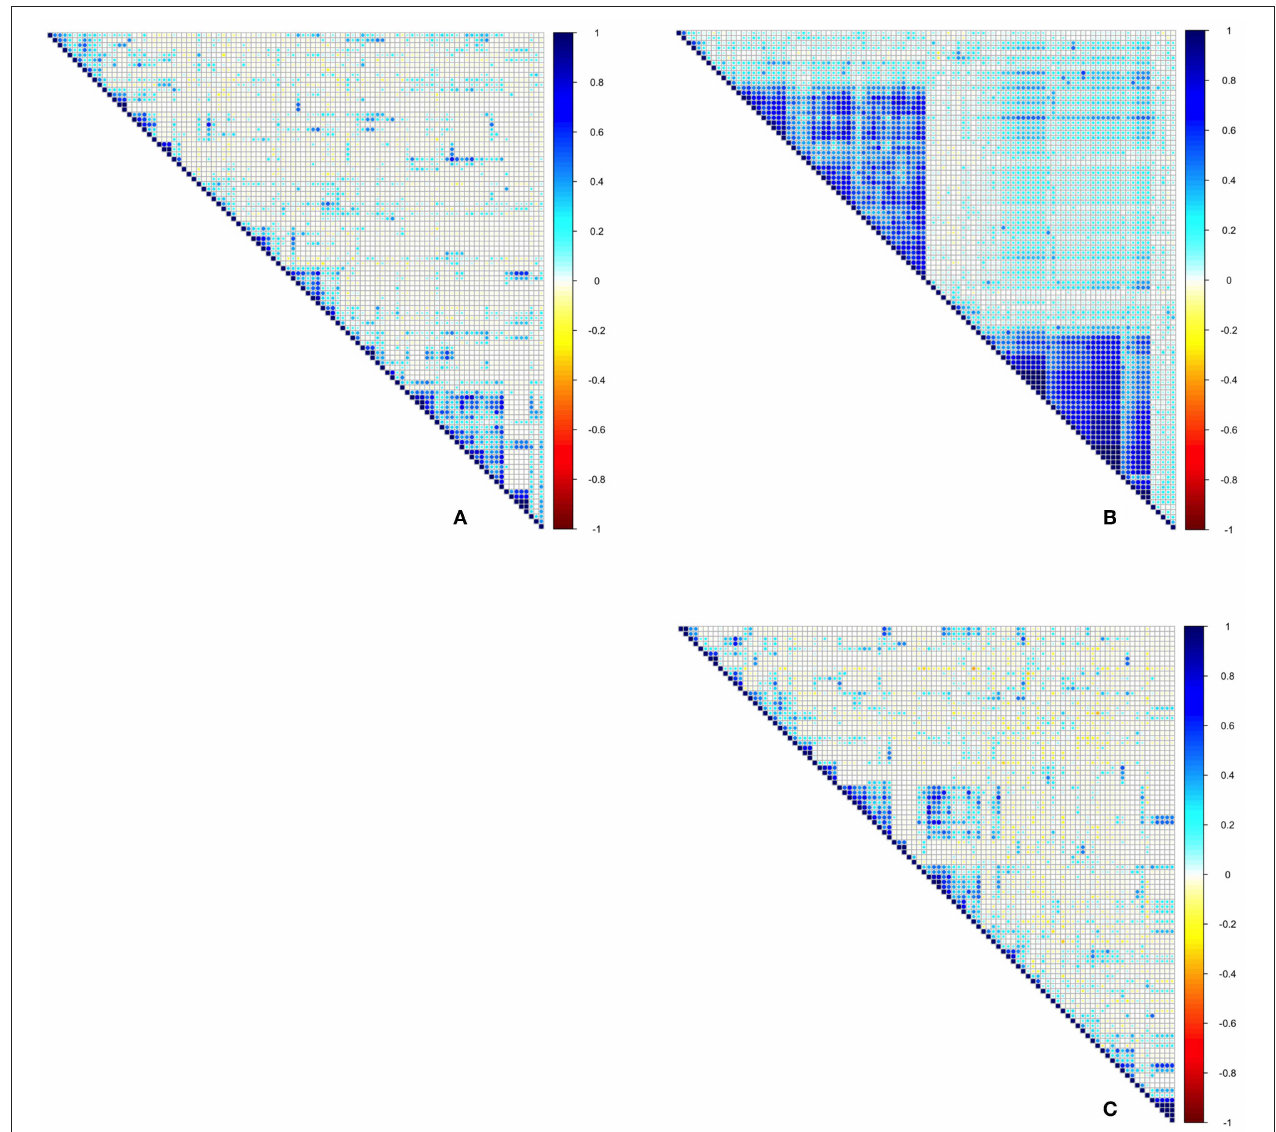
FIGURE 3 | Spearman correlation plots for the 100 most abundant OTUs for (A) Bacteria-Bacteria, (B) Fungi-Fungi, (C) Bacteria-Fungi. Colouration from blue to red indicates whether OTUs consistently co-occur across samples through to whether OTUs consistently never occur